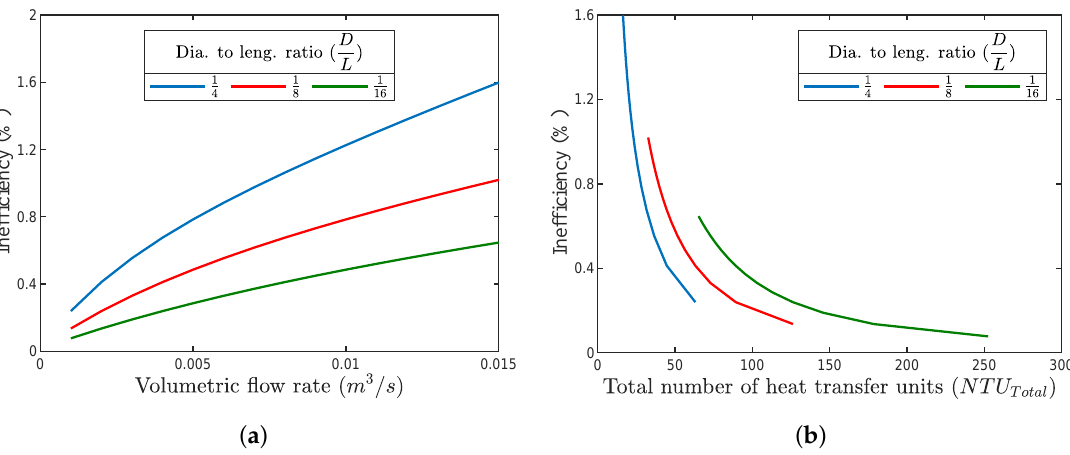
Figure 9. ( a ) Effect of increasing the volumetric flow rate on the regenerator’s inefficiency (Ie) for different regenerator diameter to length ratios. ( b ) Relation between NTU Total and Ie for the same regenerator diameter to length